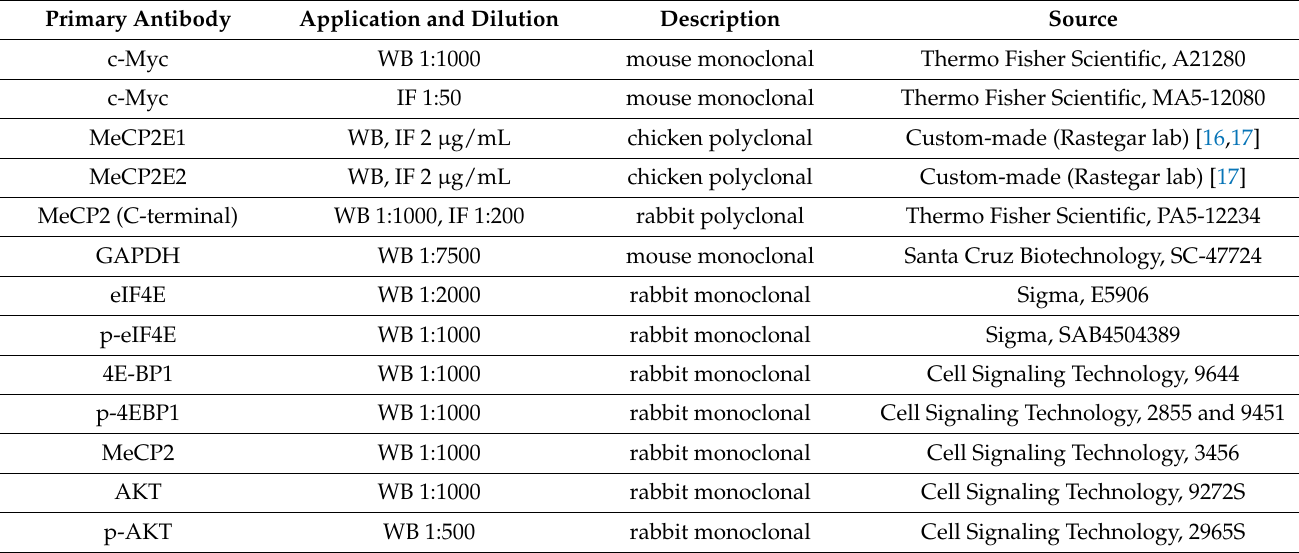
Table 1. Primary antibodies used in Western blot and immunofluorescence.